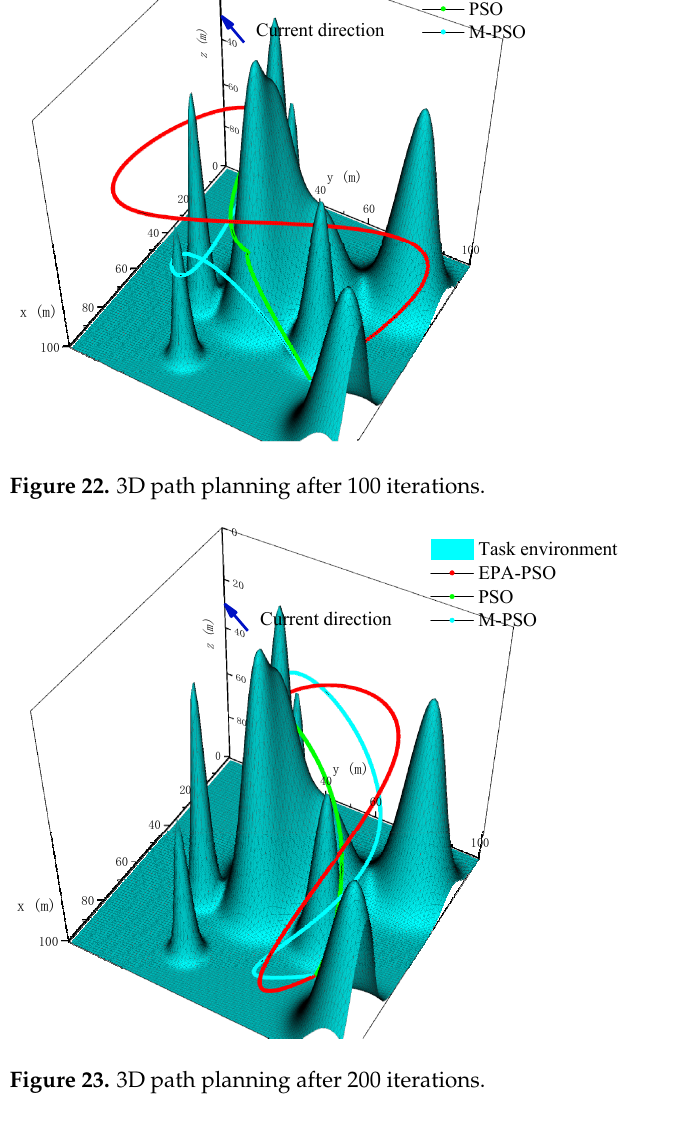
Figure 23. 3D path planning after 200 iterations.